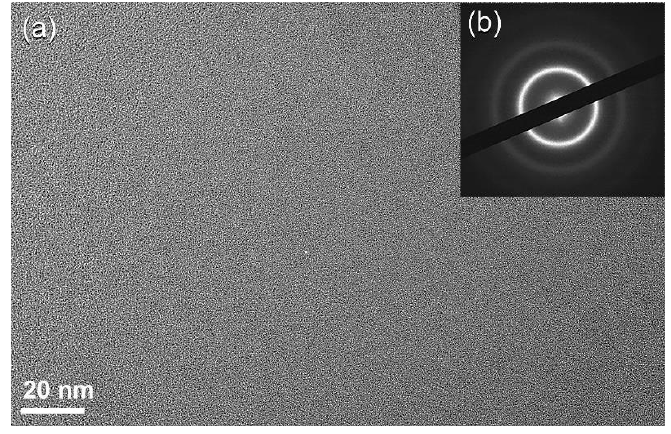
Figure 8. XRD diffraction patterns and FE-SEM images of the powders obtained after ball milling for ( a ) 0 h, and ( b ) 12 h, respectively. In ( c–e ), the XRD patterns and corresponding FE-HRTEM, NBDP of the sample obtained after 10 h are shown. The XRD patterns for the samples milled for 16 h and 28 h are displayed in ( f , g ), respectively. micrograph of graphite powders produced after 0 and 12 h of high energy ball milling, respectively.